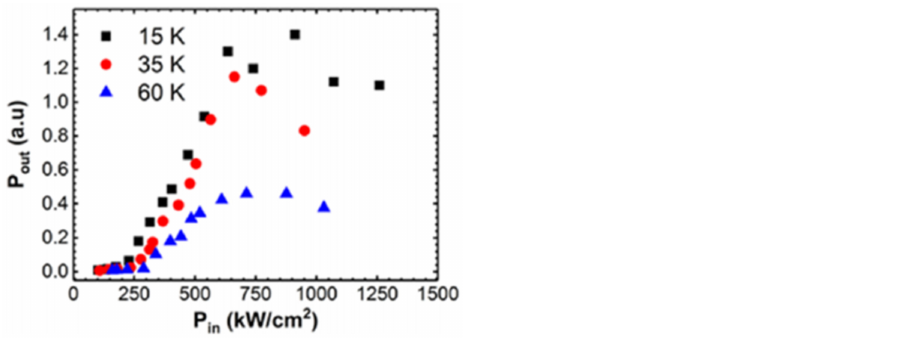
Figure 34. L–L curves for a photonic crystal GeSn laser with an Sn content of up to 16%. Reproduced with permission from [72], AIP Publishing, 2018.